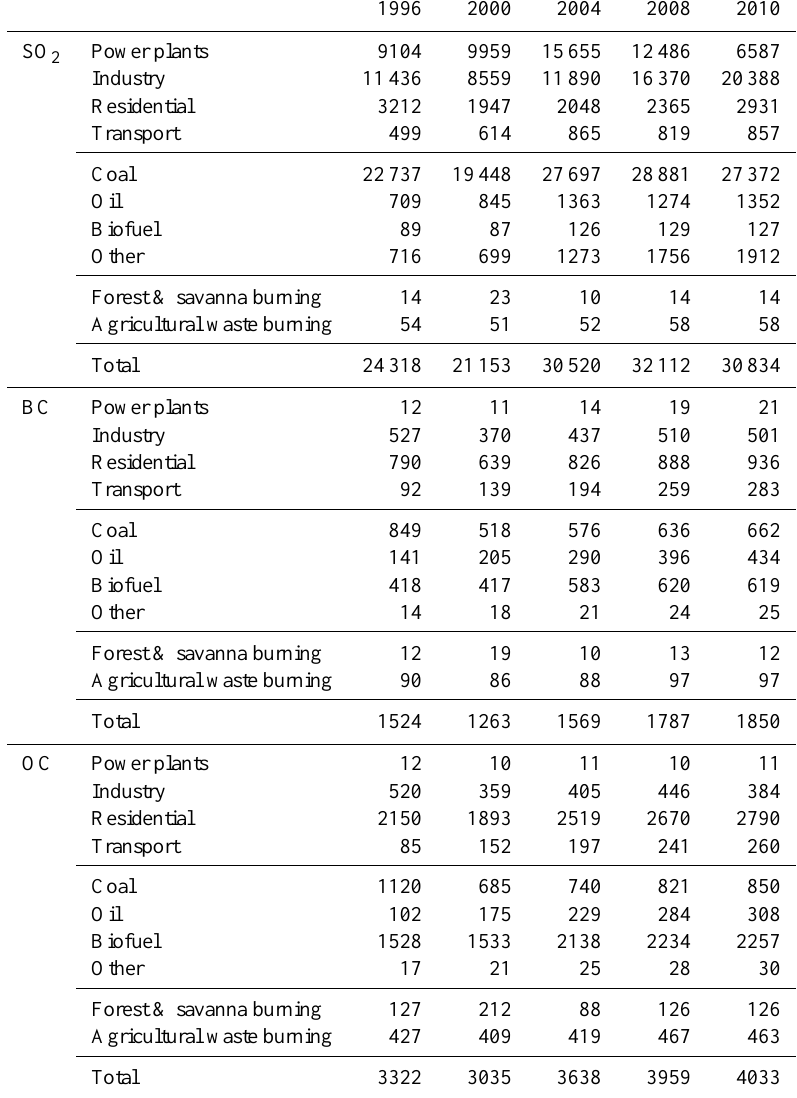
Table 1. Emissions of SO 2 , BC, and OC in China by sector and fuel type